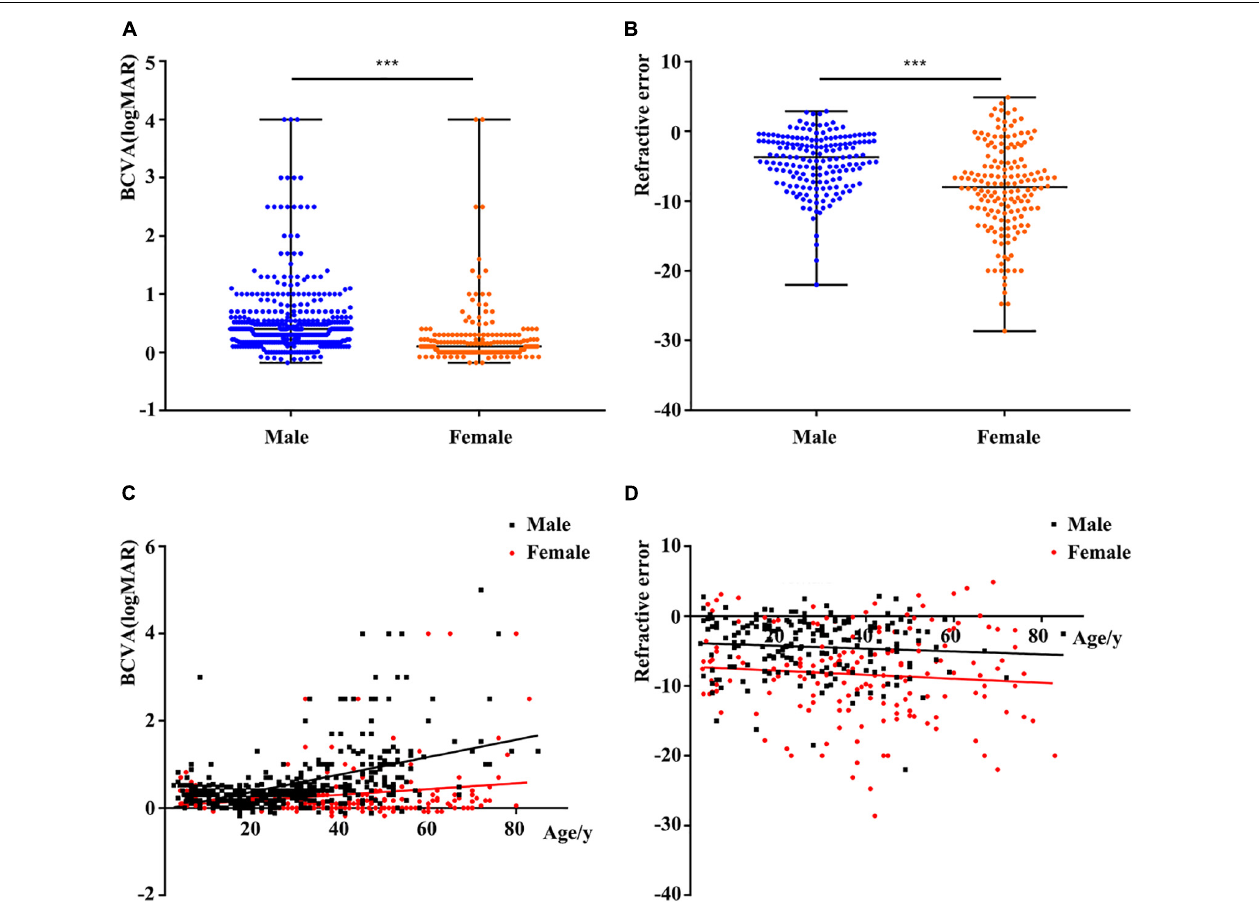
FIGURE 2 | Comparison of phenotypes according to different factors. (A) Comparison of logMAR BCVA between males and females. The BCVA of female carriers was better than that of male patients. (B) Comparison of refractive error (RE) between males and females. Spherical equivalent refraction represents the severity of RE. The RE of female carriers was more serious than that of males. (C) Scatterplots of logMAR BCVA and age, the two fitted lines correspond to male (black) and female (red) patients. A significant reduction of BCVA with increase of age in both males and females. (D) Scatterplots of RE and age, the two fitted lines correspond to male (black) and female (red) patients. The trends of the two lines are basically smooth. BCVA, best corrected visual acuity. ***, P value less than 0.001.